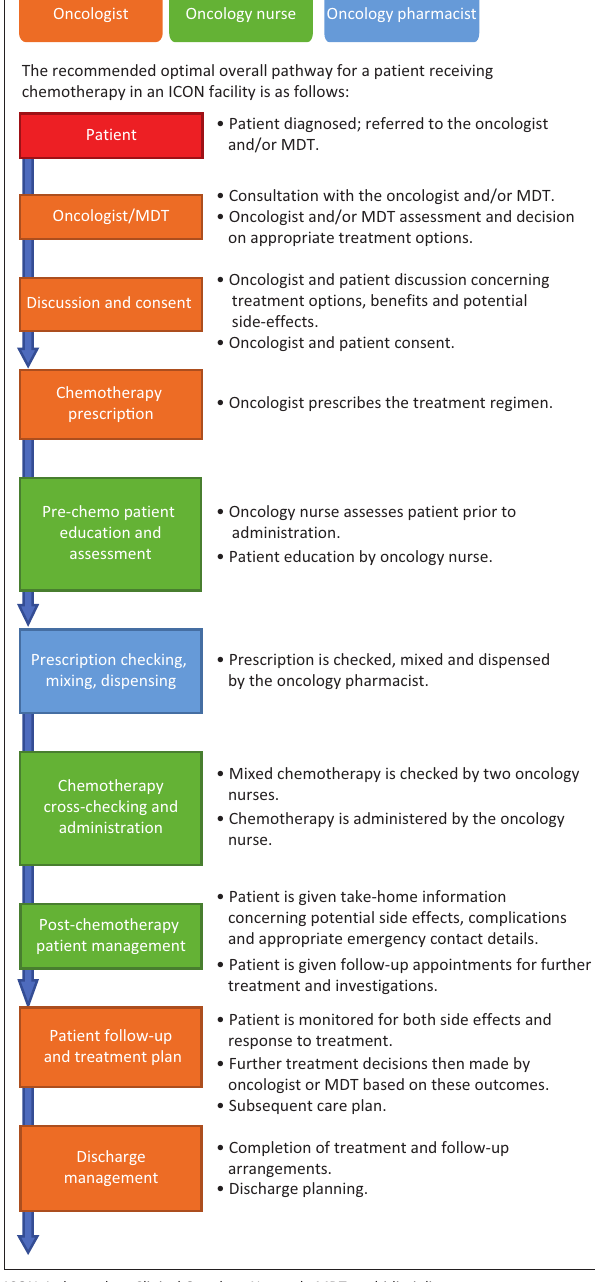
FIGURE 1: The Chemotherapy Patient